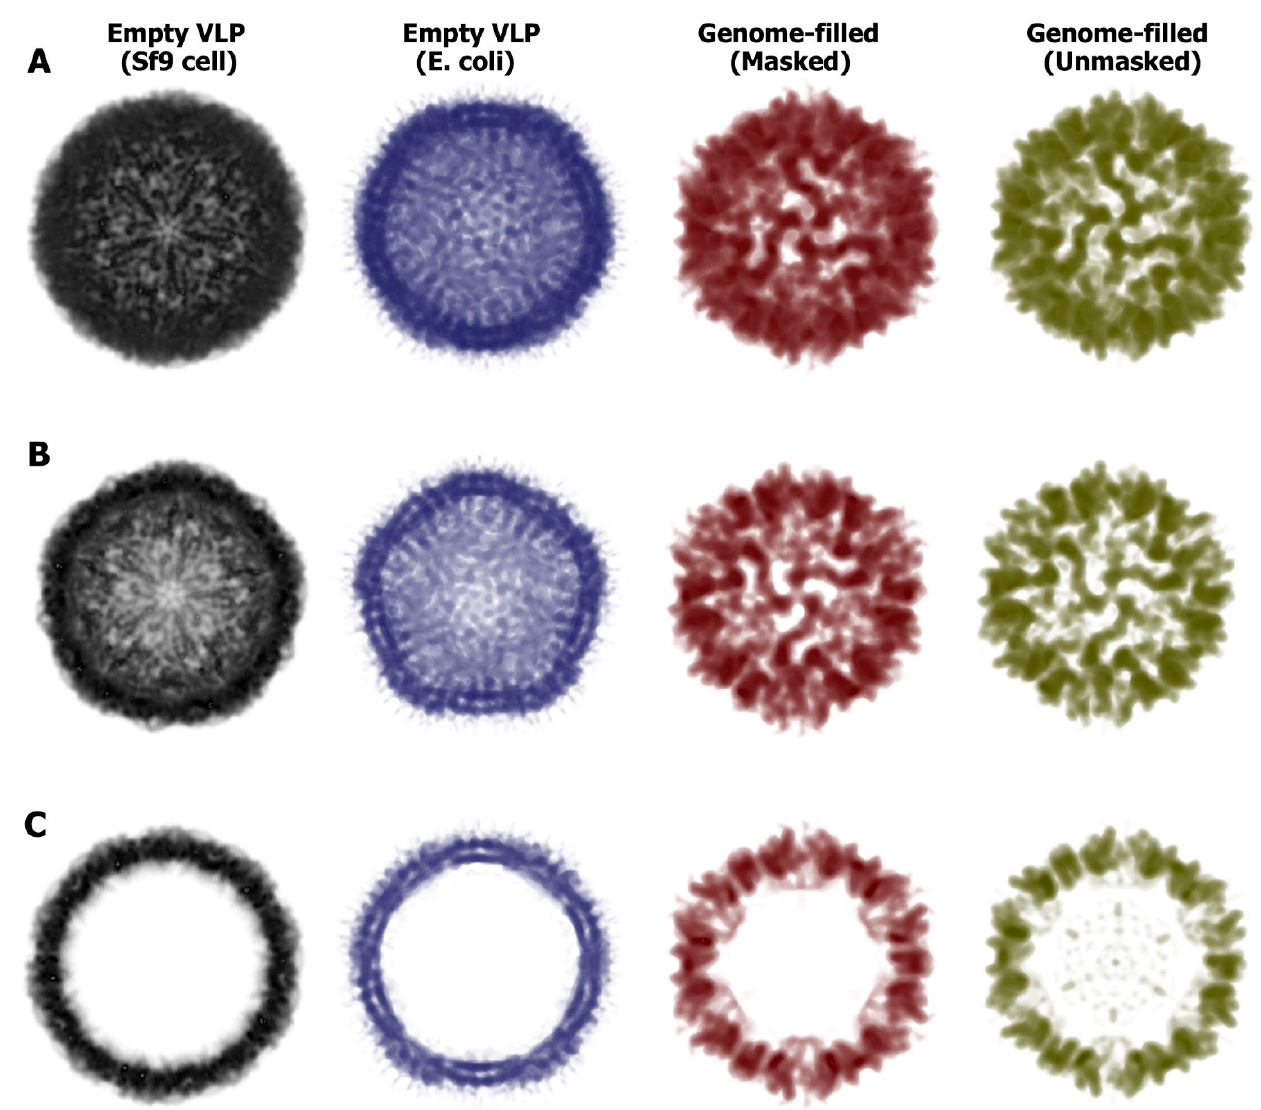
Figure 3. Electron density maps of the empty and dsDNA-filled VLPs. The data from empty IHHNV-VLP (PDB accession # 3N7X) produced in Sf9 insect cells were reconstructed (first column, solid dark) for the purpose of comparison with the empty IHHNV-VLP produced in E. coli (second column, purple) in the full particle view (row ( A )), half-sphere view (row ( B )), and mid-section view (row ( C )). The maps of dsDNA-filled VLP are shown as the genome-masked (third column, deep red) and unmasked (fourth column, green) particles in views corresponding to the empty VLP.